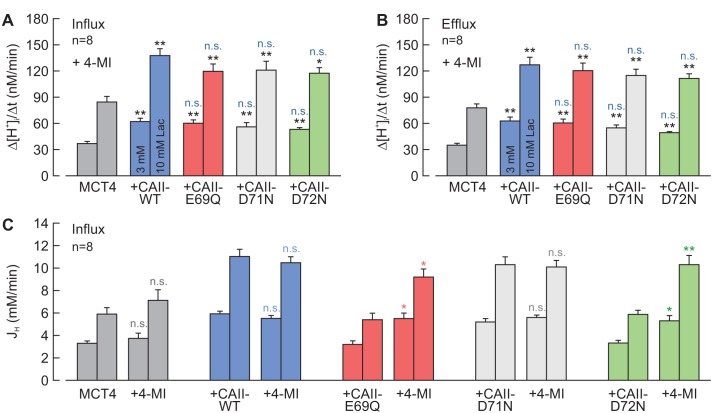
Chemical rescue of the interaction between MCT4 and CAII-E69Q/D72N by 4-methylimidazole.(A, B) Rate of change in intracellular H+ concentration (Δ[H+]/Δt) as induced by the application (A) and removal (B) of 3 and 10 mM lactate, respectively, in oocytes expressing MCT4 (dark gray), MCT1 + CAII-WT (blue), MCT4 + CAII-E69Q (red), MCT4 + CAII-D71N (light gray), and MCT4 + CAII-D72N (green), in the presence of 4-MI in the cytosol (mean + SEM). The black significance indicators refer to MCT4, the blue significant indicators refer to MCT4 + CAII-WT. (C) Lactate-induced proton flux (JH), as calculated from the rate of change in pHi and the cells' intrinsic buffer capacity (βi; Figure 4—figure supplement 1). The significance of difference indicators above the bars from 4-MI-injected oocytes refer to comparisons with the cells expressing the same proteins without 4-MI. *p≤0.05, **p≤0.01, ***p≤0.001. n.s. no significance; Student’s t-test.